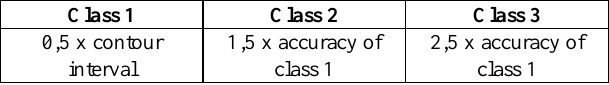
Table 1. Indonesia Topographic Map accuracy